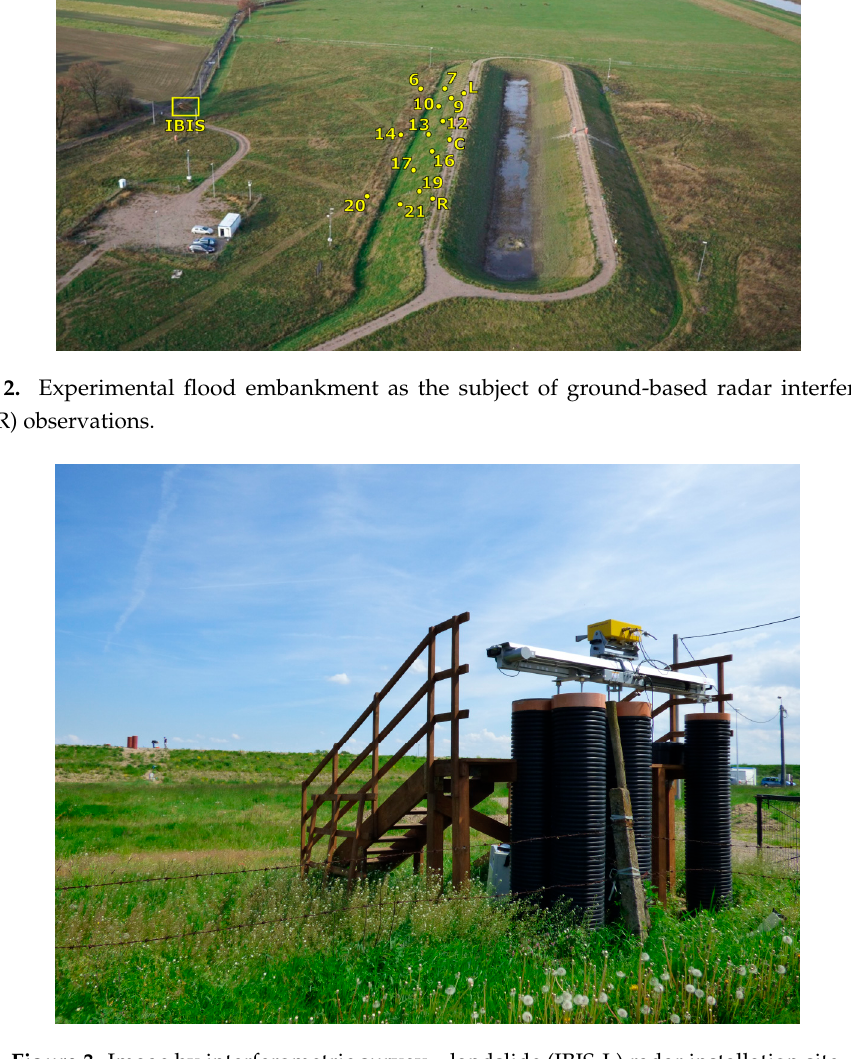
Figure 3. Image by interferometric survey—landslide (IBIS-L) radar installation site.